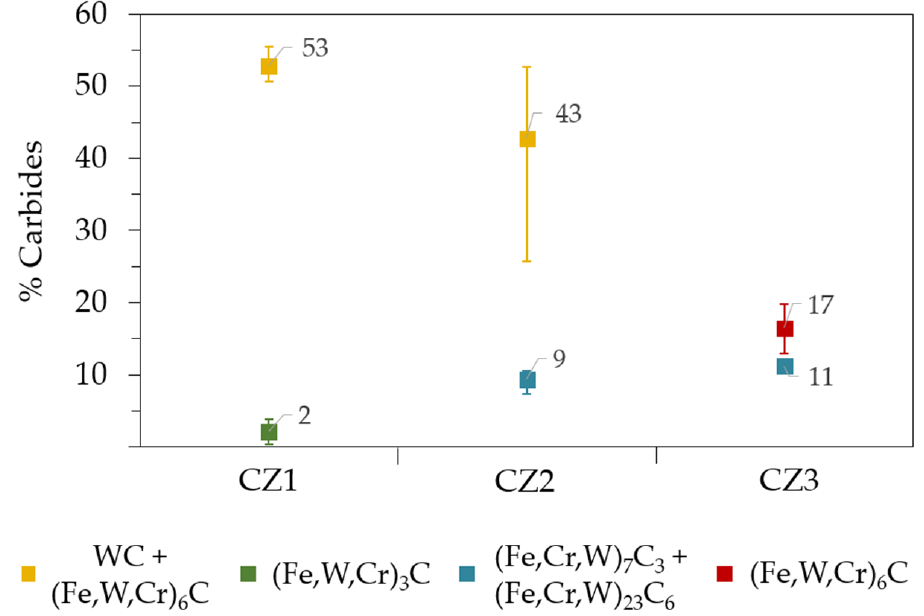
Figure 5. Amount of carbides present in each composite zone.